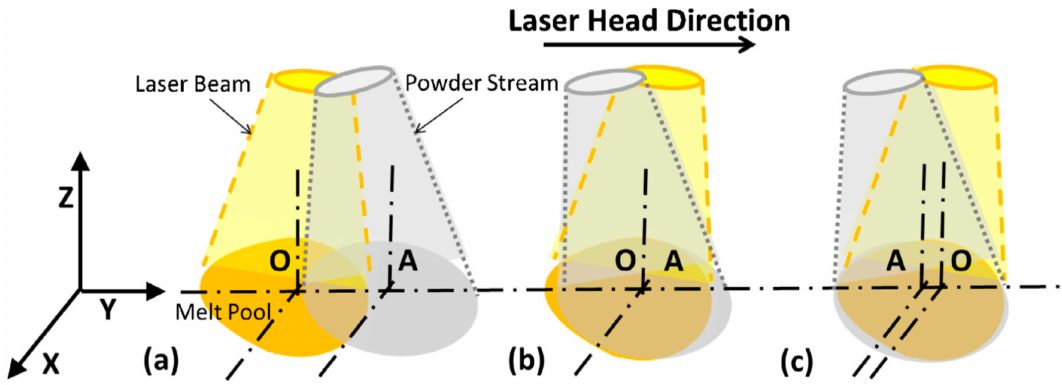
Figure 11. Powder injection point, A, ( a ) ahead of, ( b ) in-line with, and ( c ) behind the laser spot center, O (reproduced with permission from [18] Copyright Elsevier,